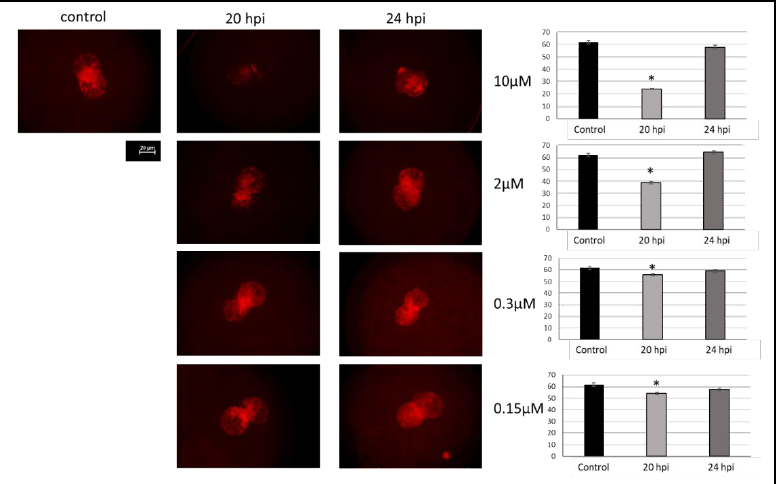
Figure 3. Evaluation of the effect of aphidicolin on reversible inhibition of DNA replication in porcine zygotes. In vitro derived zygotes were fixed and stained 20 h after insemination (20 hpi) after being cultured without aphidicolin (Control) and with different concentrations (0.15, 0.3, 2, and 10 µ M) of aphidicolin. Half of them were washed and in vitro cultured without aphidicolin for 4 h, and then fixed (24 hpi). Images of zygote pronuclei stained with Click-iT™ EdU Alexa Fluor™ Imaging Kit assessed at 20 and 24 hpi are shown. Red fluorescence shows DNA after replication. Images were processed with Image J software (NIH) and relative fluorescence was assessed. Fluorescence intensity was relativized with respect to the pronucleus with the highest signal intensity. Comparison between the control group and zygotes 20 hpi and 4 h after removing aphidicolin (24 hpi) was performed. * Indicates significant differences with the other groups at a specific aphidicolin concentration ( p < 0.05). Scale bar: 20 µ